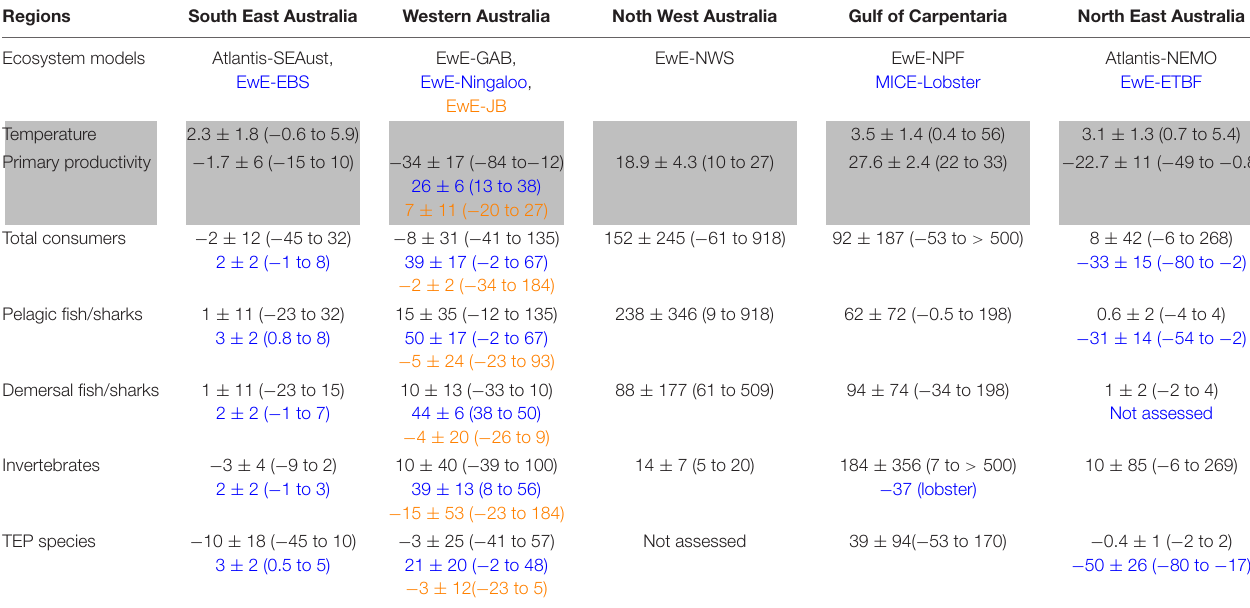
TABLE 3 | Relative percentage changes (mean standard deviation with minimum and maximum values provided in parentheses) in regional climate and ecosystem model projections averaged over model domains between 2010 and 2050. Climate model projections of temperature or primary productivity (highlighted in gray) represent mean differences between control and RPC8.5 scenarios. Biomass changes of ecological groups represent anomalies for the climate change impact only scenario. Colored values match the color used to represent different ecosystem models in the same column.